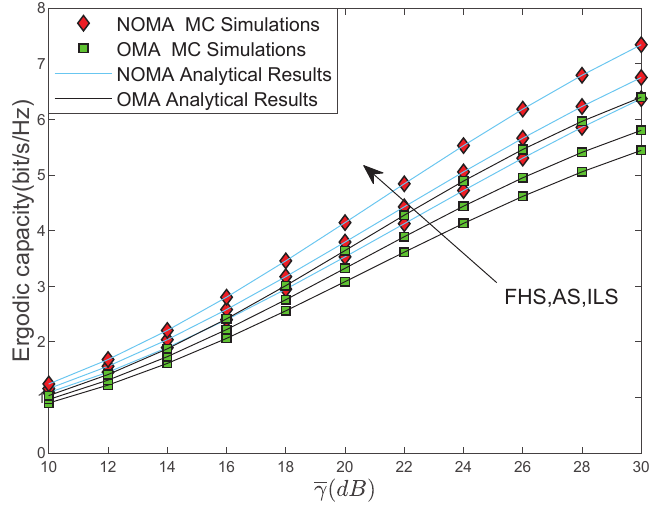
Figure 6. EC versus ¯ γ with NOMA and